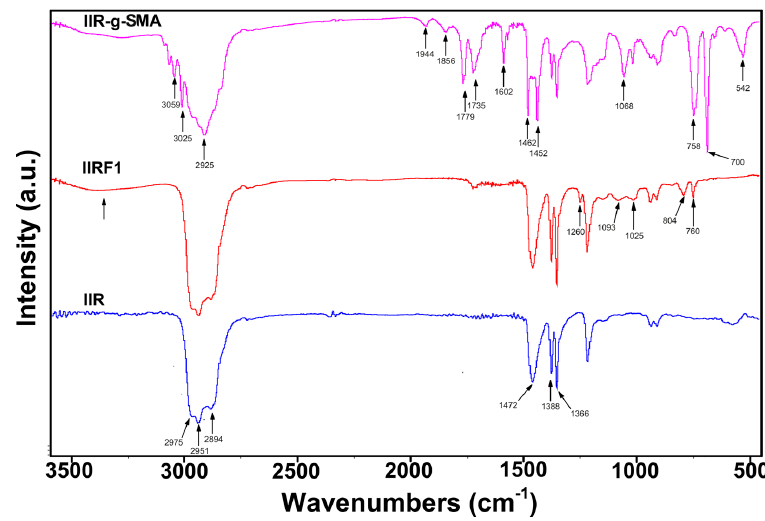
Figure 1. FTIR spectra of IIR (blue), IIRF1 (red), and LG IIR-g-SMA (pink).